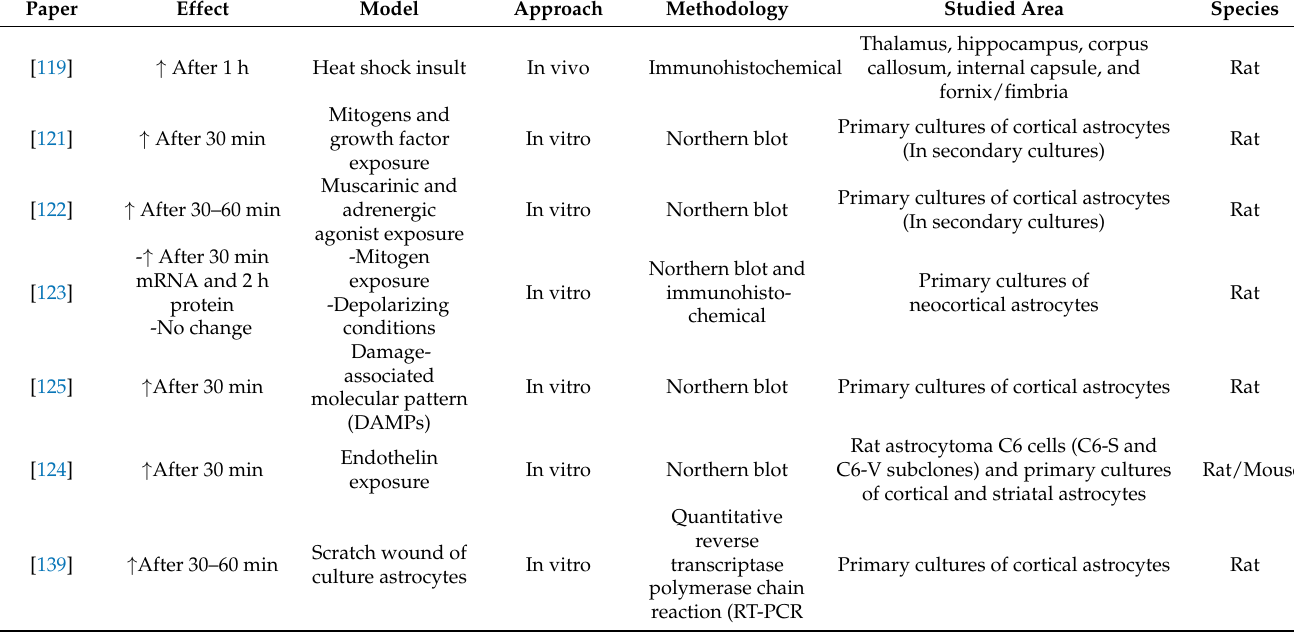
Table 1. Papers evidencing c-fos expression in astrocytes. Arrows indicate ↑ increased expression or ↓ diminished expression under different stimulation